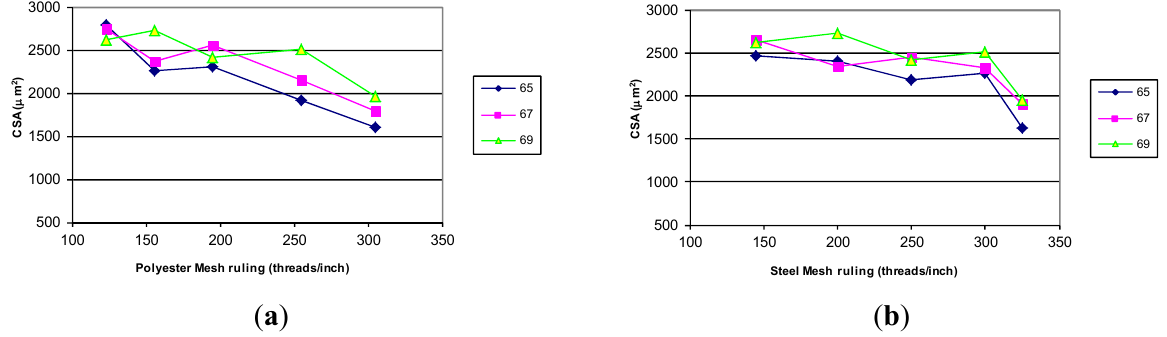
Figure 6 . The effect of mesh ruling on the cured cross sectional area of the paste inks for a nominally 200 μ m line ( a ) polyester and ( b ) stainless steel meshes.